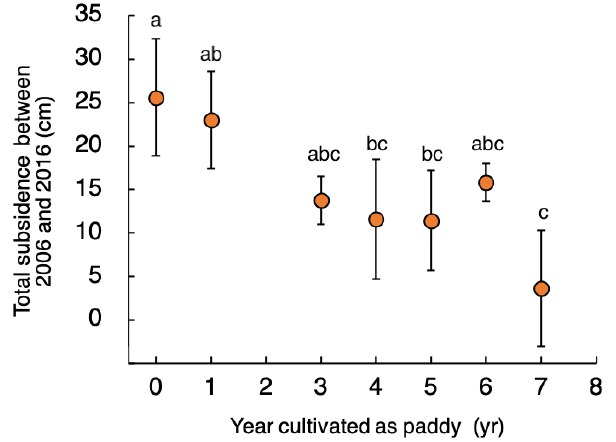
Figure 4. Relationship between total subsidence from 2006 to 2016 and the years that each field was used as paddy field (out of eight years which the satellite image is available). The error bars rep- resent the standard deviation of the samples. The plots with the same letter are not significantly different in the Tukey-Kramer test ( p